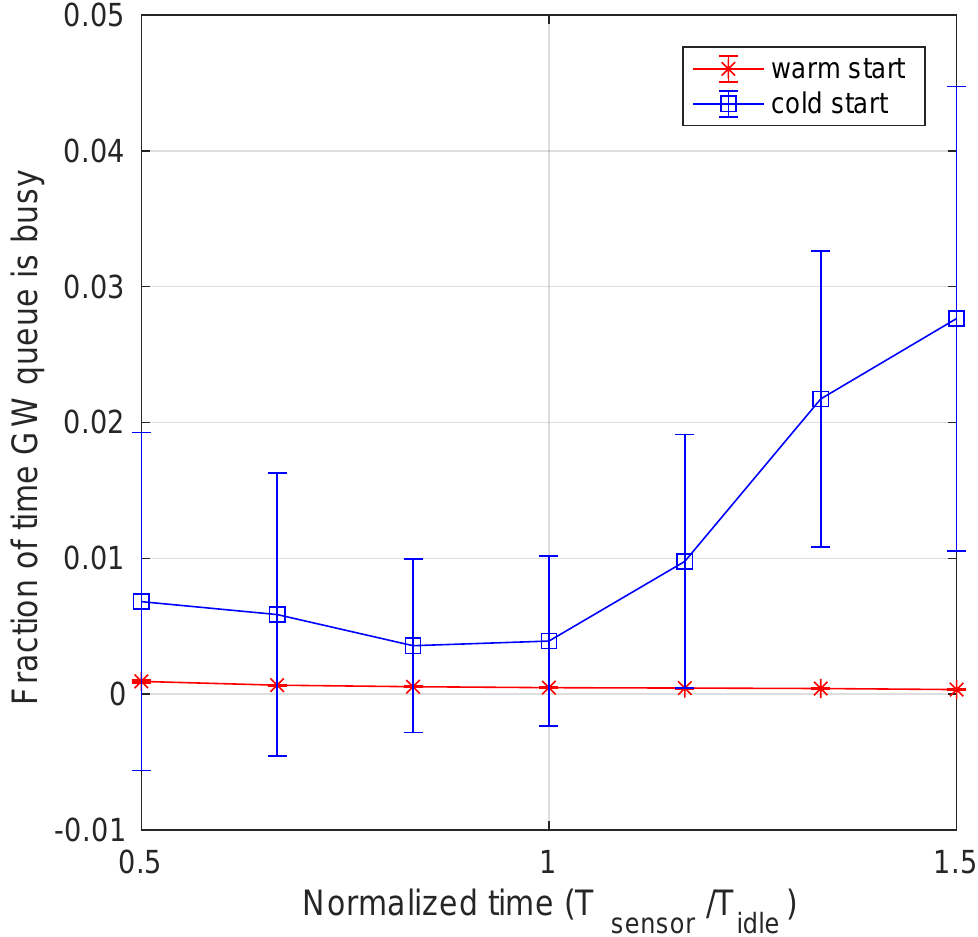
Figure 13. Fraction of time the OpenFaaS Gateway queue is busy as a function of data arrival rate for both cold and warm start. A cold start mode deployment leads to a growth of queued messages waiting for the function to become active and handle